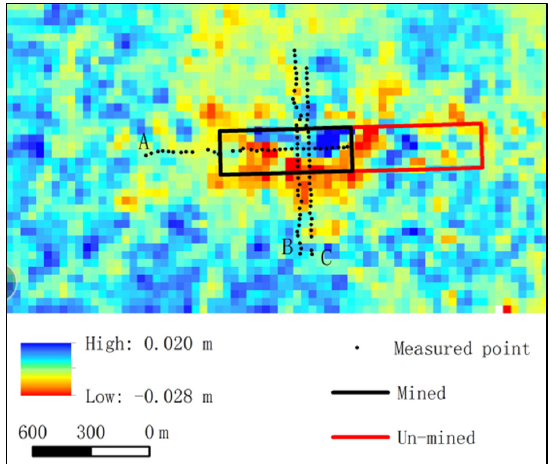
Figure 3. Illustration of the DInSAR processing results.